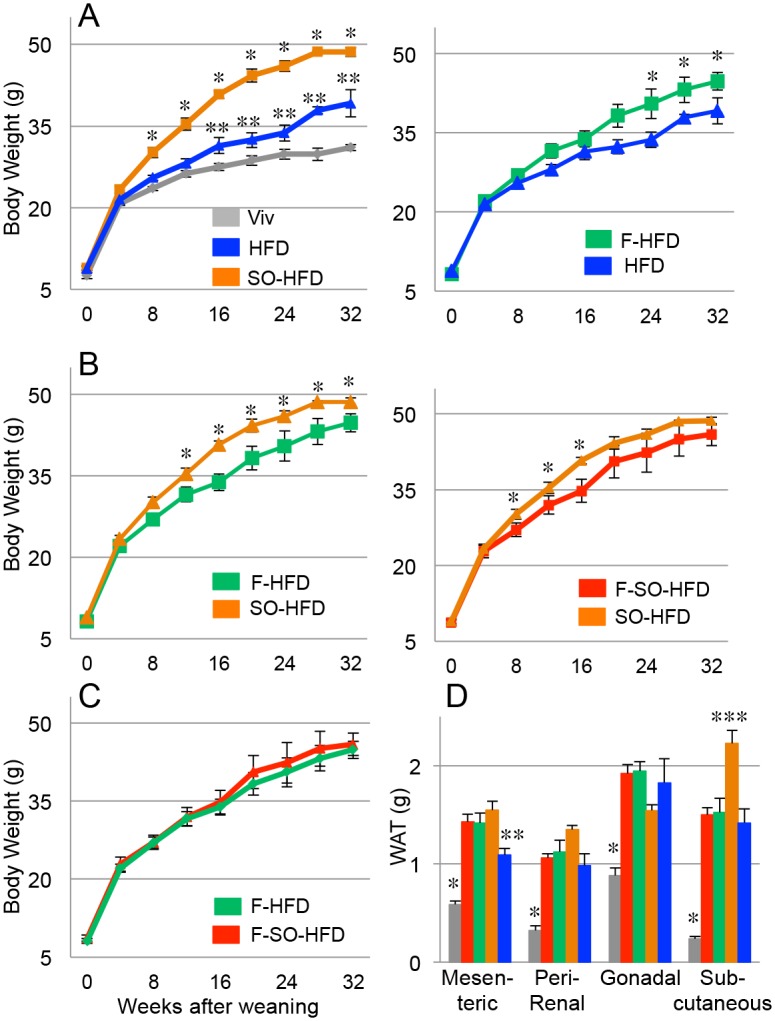
Soybean oil induces greater weight gain and adiposity than fructose.
A-C) Average weekly body weights of male C57/BL6 mice started on the indicated diets at weaning. All diets are isocaloric with 40 kcal% total fat except Viv chow, which has 13.5 kcal% fat. HFD, high fat diet largely from coconut oil; SO-HFD, high soybean oil diet; SO-F-HFD, high soybean oil and high fructose diet; F-HFD, high fructose diet. N = 6–12. * Significantly higher than all others; ** HFD significantly higher than Viv. Significance is defined as P ≤ 0.05 by Student’s T-test. D) Average weight of different types of white adipose tissue. Diets are color coded as in A-C. * Significantly lower than all others; ** HFD significantly lower than SO-HFD; *** SO-HFD significantly higher than all others; N = 6–12 per diet. Significance is defined as P ≤ 0.05 by ANOVA with Tukey’s post-hoc analysis.